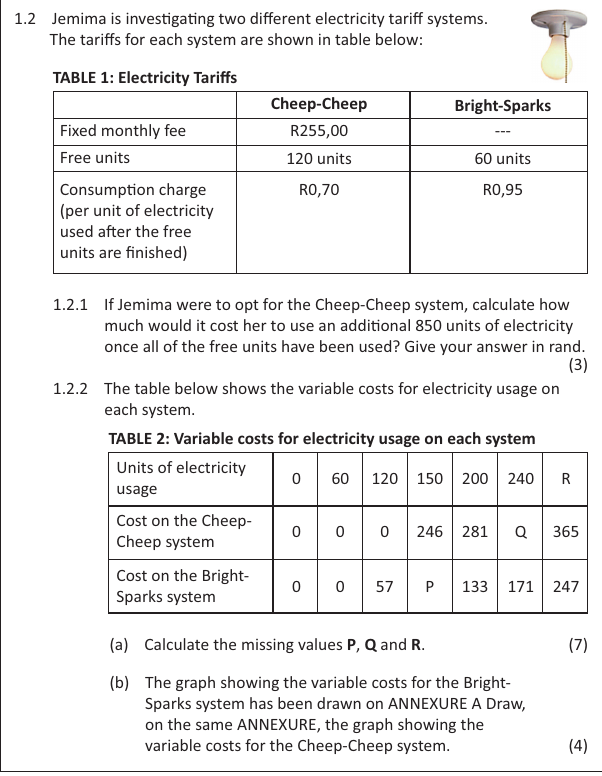
FIGURE 2: Remodelled version of a Paper 1 examination question.